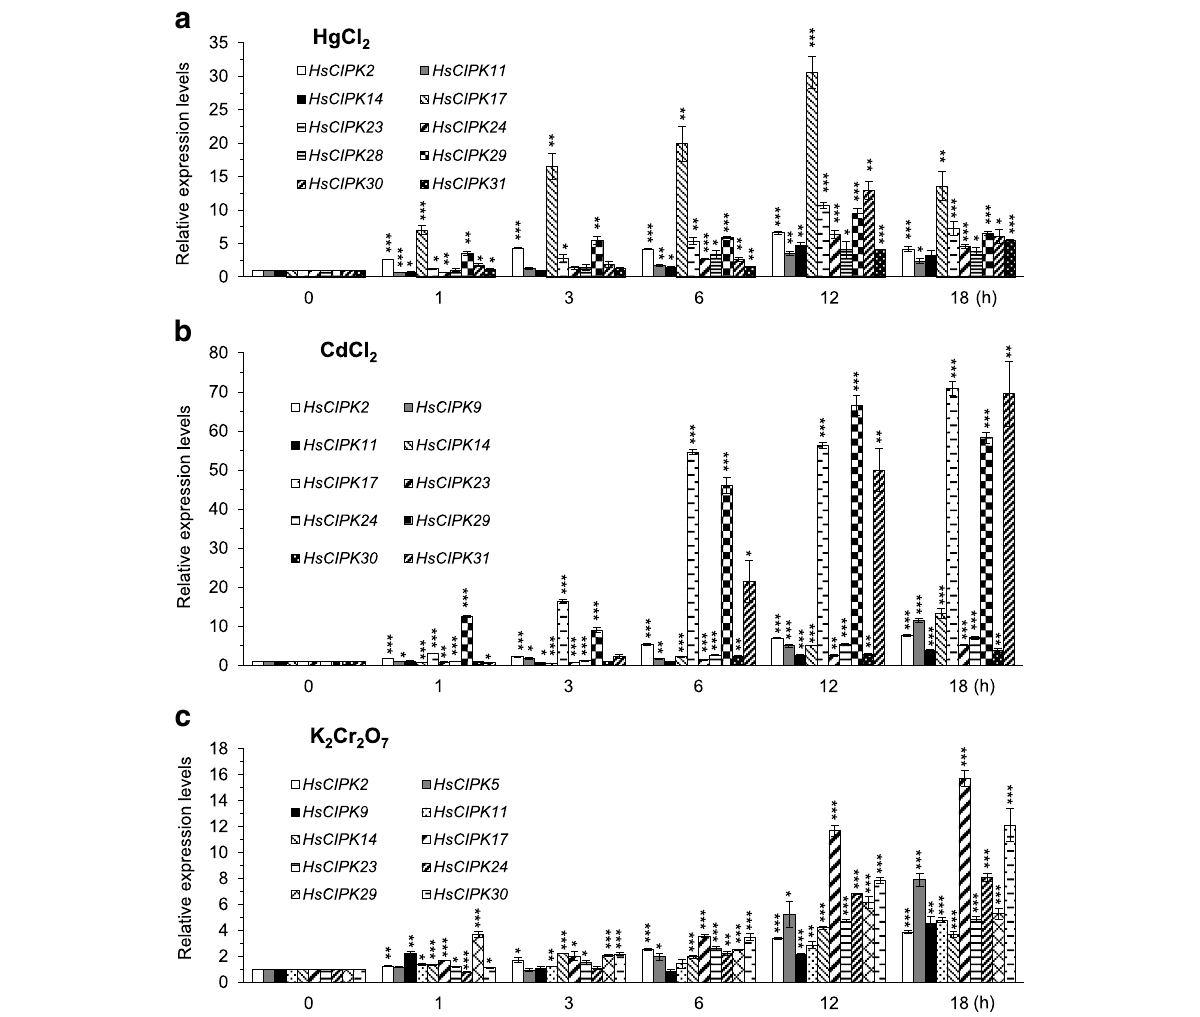
Fig. 2 Hg-, Cd-, and Cr-induced expression patterns of HsCIPKs . a-c Relative expression levels of HsCIPKs in four-day-old wild barley seedlings treated for different time lengths (0, 1, 3, 6, 12, and 18 h) with 20 μ M HgCl 2 ( a ), 20 μ M CdCl 2 ( b ), and 0.5 mM K 2 Cr 2 O 7 ( c ), respectively. Values shown are means ± SD. Single, double, and triple asterisks indicate P < 0.01, 0.001, and 0.0001, respectively ( t test; compared to the corresponding 0-time point mock control). The expression level of the 0-time point mock control for each HsCIPK was set as